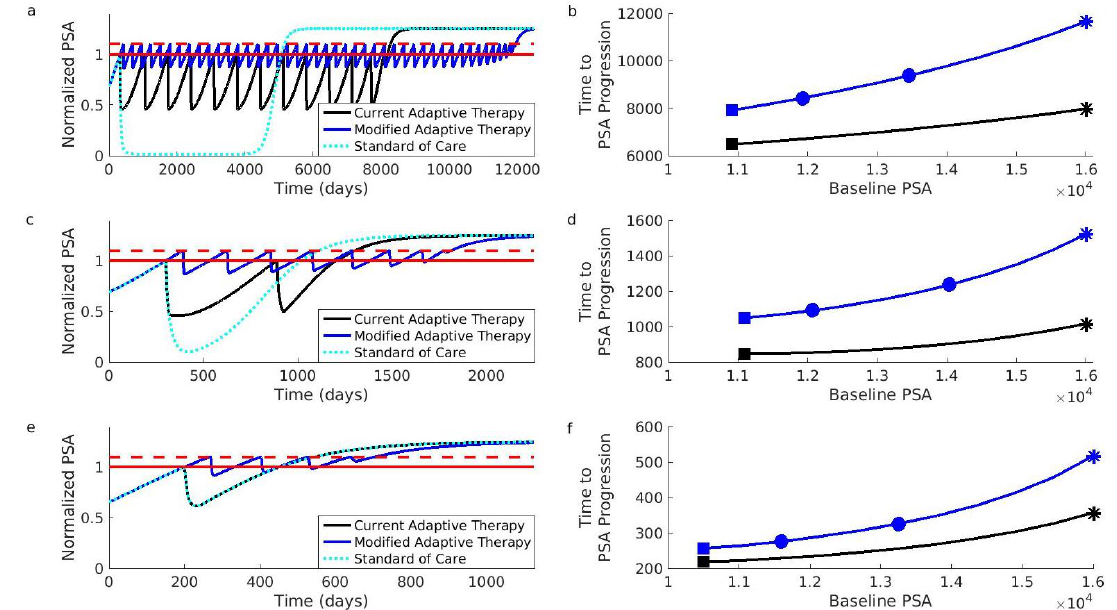
Figure 3. Simulations comparing current and modified adaptive therapy designs. The comparison was performed for three different types of patients. These patients differed in their initial resistance frequencies: low (Patient 1, Panels ( a , b )), medium (Patient 2, Panels ( c , d )), and high (Patient 3, Panels ( e , f )). ( a ) Comparison for Patient 1 assuming that the initial baseline (solid red) cannot be increased. The modified design (blue) controls the PSA for longer than the current design (black). Both adaptive therapy designs are better than the standard of care (dotted light blue curve). To facilitate comparison, PSA progression for both designs occurs when the PSA exceeds 10% of the baseline (dashed red). The PSA is normalized relative to initial baseline PSA. ( b ) Time to PSA progression for Patient 1 under the modified (blue) and current (black) adaptive therapy design. If the current design is implemented at the initial baseline indicated by the black square, the modified design implemented at the same baseline would improve the results (blue square). However, increasing the baseline by 10% (leftmost blue circle) or 25% (rightmost blue circle) improves the results further. Asterisks correspond to the dynamics shown in ( a ). ( c , d ) Same as ( a , b ) except for Patient 2. ( e , f ) Same as ( a , b ) except for Patient 3. Notice that Patient 3 did not achieve a 50% reduction in the PSA during the first cycle of adaptive therapy (the black curve in Panel ( e ) is always above 0.5). This means that the current adaptive therapy design coincides with the standard of care (the black curve and dotted light blue curve in Panel ( e ) lie on top of each other). Simulations use the same mathematical model as the original simulations that supported the design of the current adaptive therapy regimen [13,47]. See Section 4 for details on patient types and